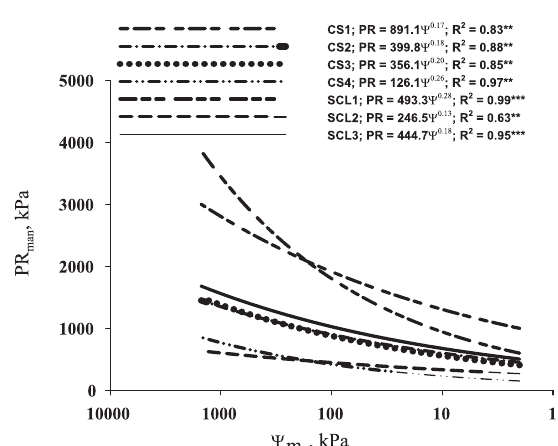
Figure 3. Soil penetration resistance (unconfined strength) in the soil samples measured with an automatic table penetrometer.